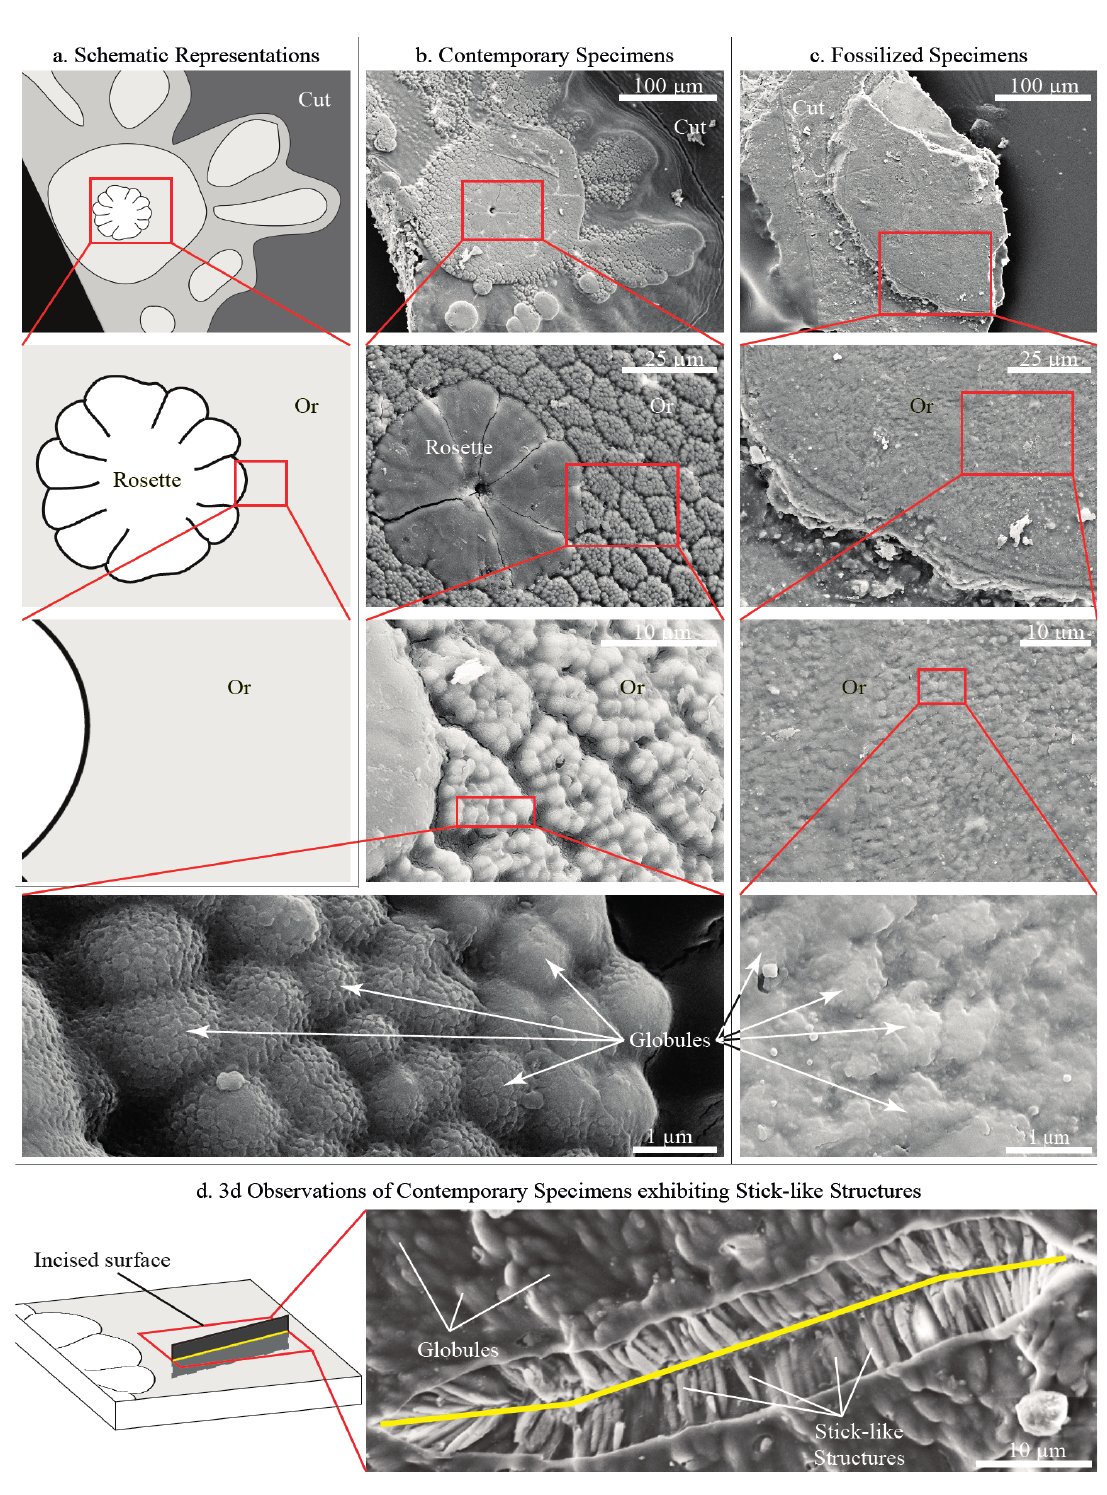
Figure 3. Fine-scale morphologies of the investigated contemporary and fossilized epibiotic calcifying bacterial colonies. ( a ) schematic representations, ( b ) SEM images (secondary electrons) of contemporary specimens and ( c ) SEM images (secondary electrons) of fossilized specimens at different magnifications (Cut = decapod cuticle, Or = ornamentations). ( d ) Schematic representation and SEM image (secondary electrons) of an incised surface of a contemporary epibiotic bacterial colony exhibiting stick-like structures outcropping at the surface in the form of